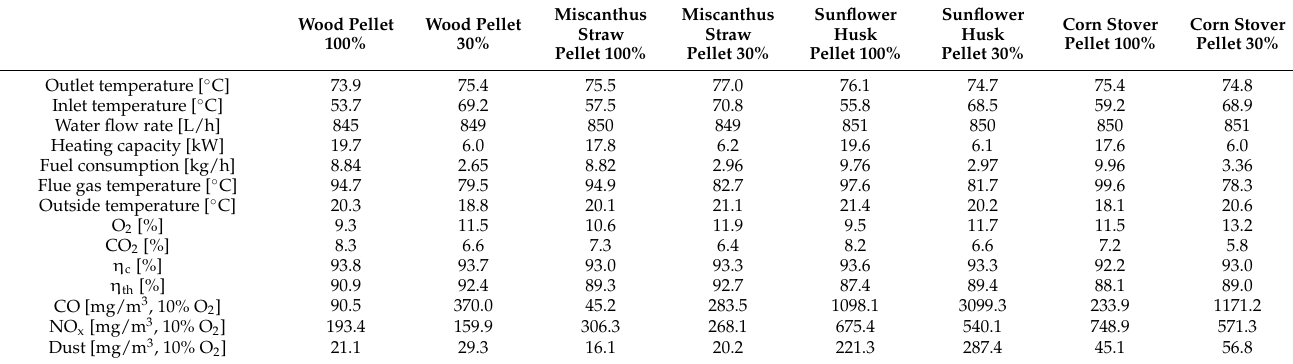
Figure 12. Combustion efficiency and boiler thermal efficiency for various types of pellets. Table 3. Average working parameters of the boiler and emissions from the combustion of various types of pellets.